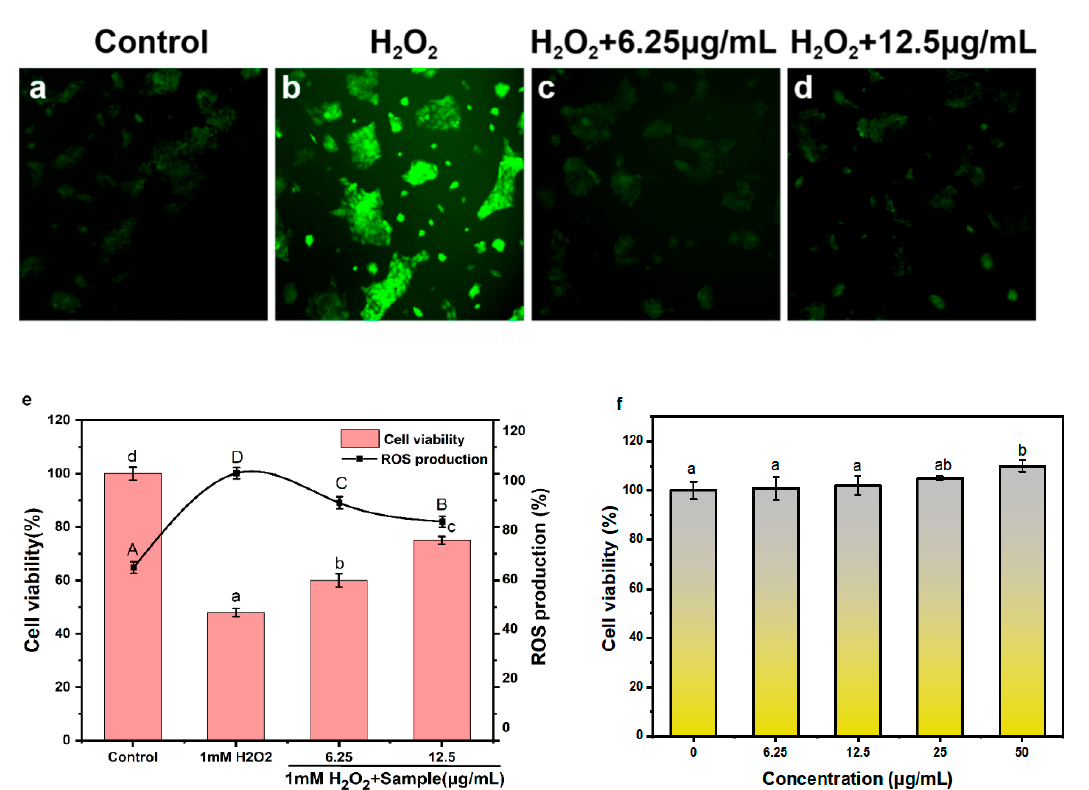
Figure 5. Antioxidant activity and cytotoxicity of HaCaT keratinocytes. ( a – d ) Fluorescent images of HaCaT keratinocytes treated with H 2 O 2 and PPNPS (1:8) and stained with H 2 DCFDA probe. ( e ) Cell viability and relative fluorescence intensity of HaCaT keratinocytes treated with H 2 O 2 and PPNPS (1:8, w / w ) at di ff erent concentrations. ( f ) Cytotoxicity of HaCaT keratinocytes treated with PPNPS (1:8, w / w ) at di ff erent concentrations. Data are expressed as the mean ± SD. Multiple group comparisons were performed using one-way ANOVA; data that are not denoted with the same letter are significantly di ff erent ( p < 0.05).